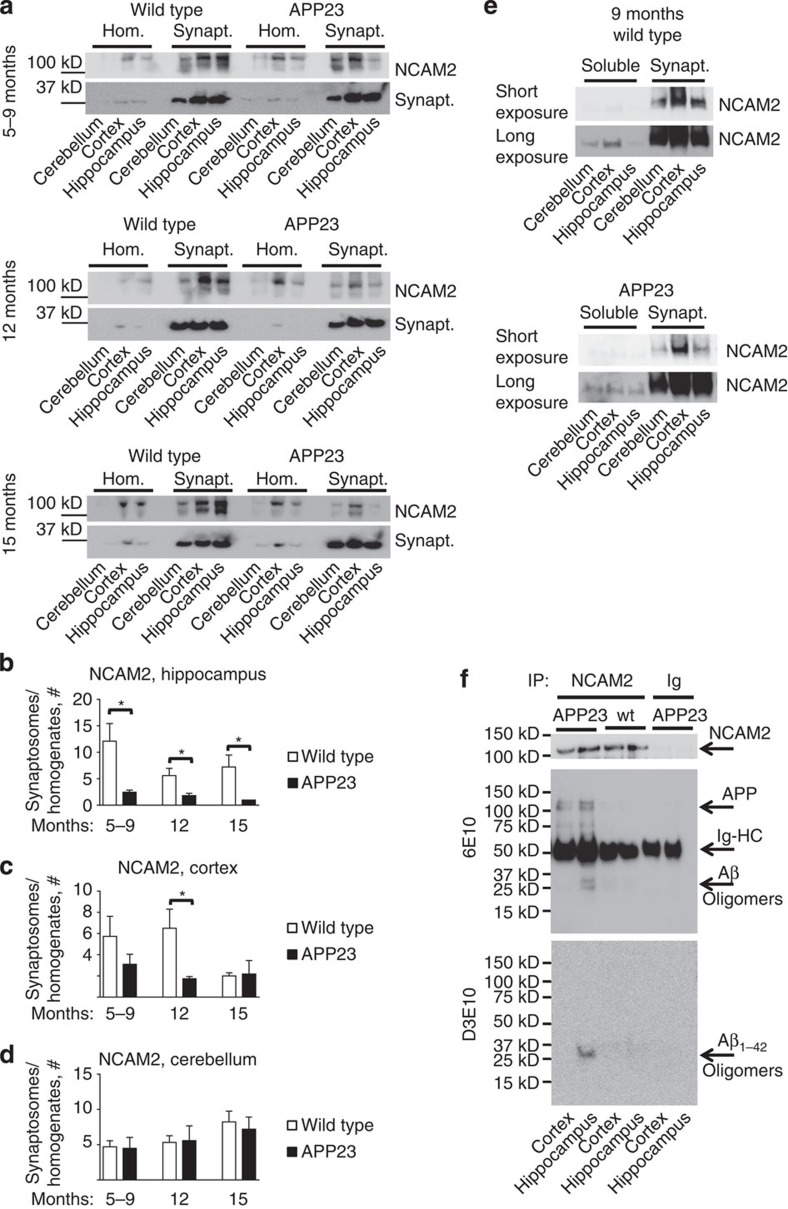
NCAM2 binds to Aβ and its synaptic accumulation is reduced in the hippocampus of APP23 transgenic mice.(a) Western blot analysis of the homogenates (hom.) and synaptosomes (synapt.) prepared using hippocampus, cortex and cerebellum from wild-type and APP23 transgenic (APPtg) mice. Probes were analysed with antibodies against NCAM2 and synaptophysin used as a loading control. Note reduced synaptic enrichment of NCAM2 in the hippocampus of APP23 transgenic mice. Full-length versions of the western blots are shown in Supplementary Fig. 11. (b–d) Graphs show synaptic enrichment of NCAM2 defined as a ratio of NCAM2 levels in synaptosomes and homogenates (mean+s.e.m., samples from four 5–9-month-old, four 12-month-old and two 15-month-old pairs of littermates were analysed twice by western blot). *P<0.05 paired t-test. (e) Western blot analysis of the soluble protein fraction and synaptosomes prepared using hippocampus, cortex and cerebellum from wild-type and APP23 transgenic mice. Probes were analysed with antibodies against NCAM2. Note reduced synaptic enrichment of NCAM2 in the hippocampus of APP23 mice (short exposure) and higher levels of soluble NCAM2 fragments in the hippocampus of APP23 mice when compared with wild-type hippocampus revealed after prolonged exposure of the blot (long exposure). Full-length versions of the western blots are shown in Supplementary Fig. 12. (f) Western blot analysis of NCAM2 immunoprecipitates (IP) from the cortex and hippocampus of wild-type and APP23 mice. Mock IP with non-immune immunoglobulins (Ig) served as control. Membranes were analysed with antibodies to NCAM2, human APP and Aβ (6E10, Covance), or Aβ1-42 (D3E10, Cell Signaling). Note full-length APP and Aβ immunoreactivity in NCAM2 immunoprecipitates from APP23 mice. A band representing the heavy chain of the immunoglobulins (Ig-HC) used for immunoprecipitation and recognized by the secondary antibodies is also observed. Labelling with antibodies to NCAM2 shows NCAM2 immunoprecipitation efficiency. Full-length versions of the western blots are shown in Supplementary Fig. 13.